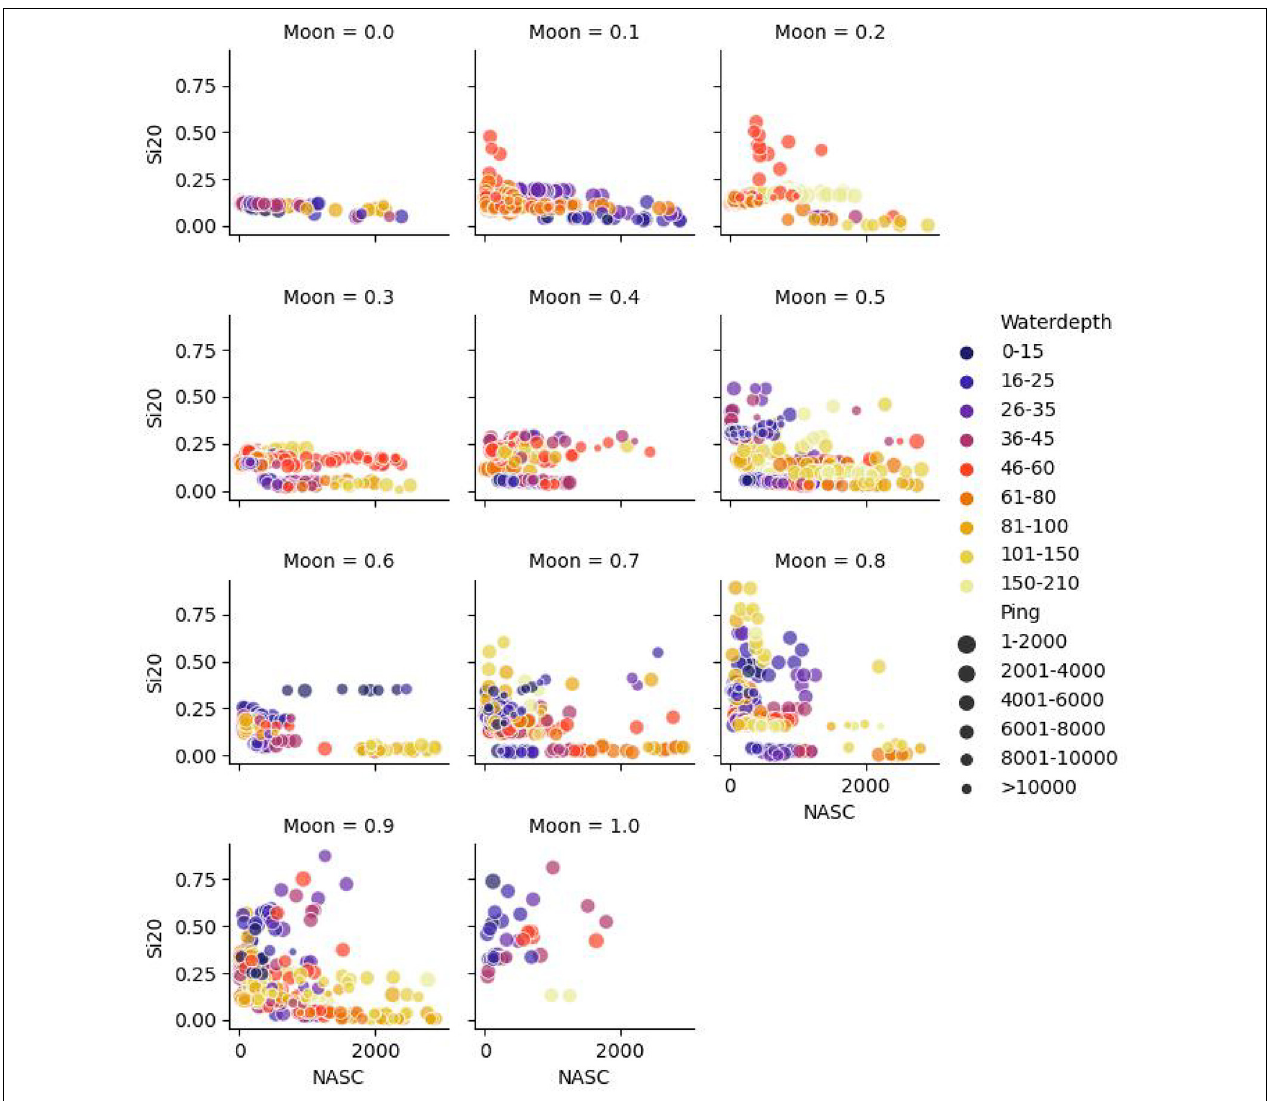
FIGURE 10 | Scatter plot of multidimensional data: the color of the points distinguishes the water depth, and the size of the points distinguishes the number of Ping in each acoustic analysis